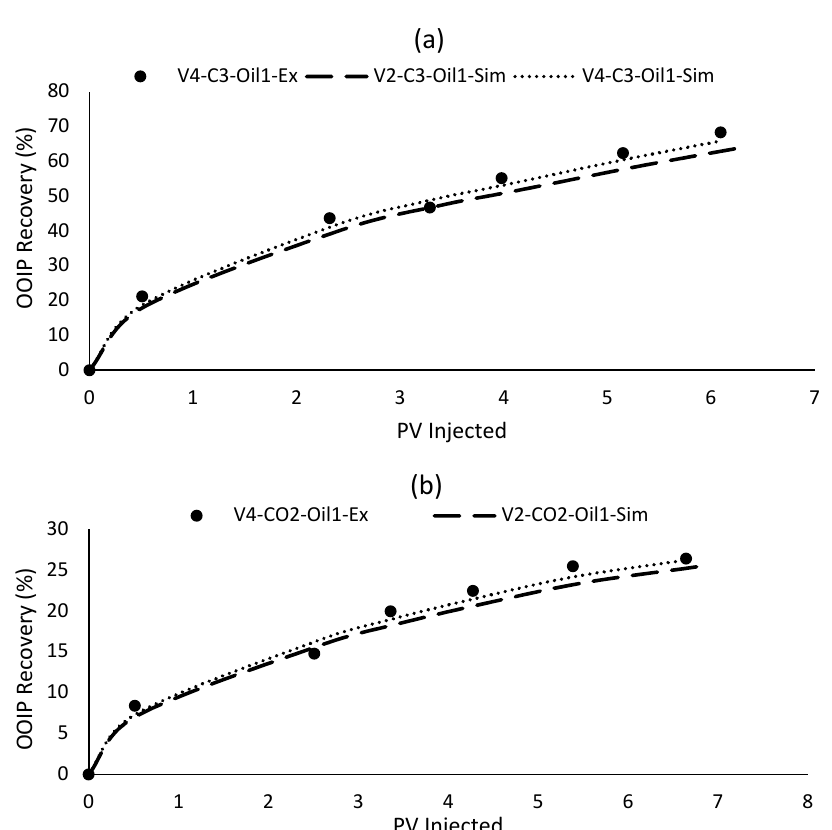
Figure 15. The effect of fracture width on the recovery factors in conventional VAPEX and patterns V2 and V4 using propane ( a ) and carbon dioxide ( b ).